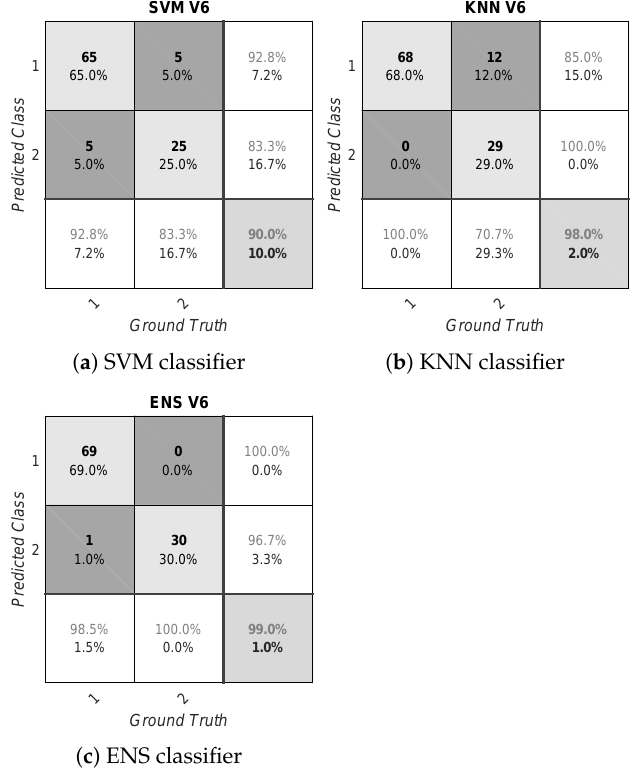
Figure A5. Confusion matrices for a subject-dependent model for V5.